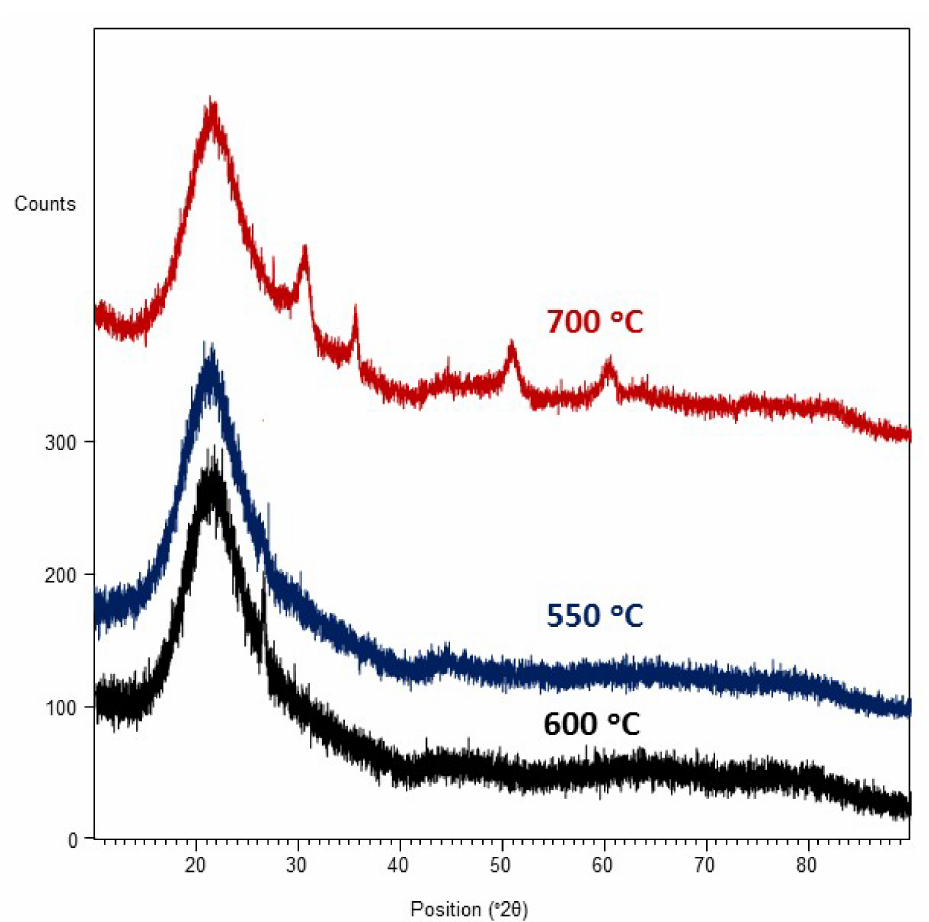
Figure 3. X-ray diffraction pattern of ZrO 2 -Gd 2 O 3 layers deposited at 550, 600, and 700 ◦ C. Molar content of Gd(tmhd) 3 in the gas reaction mixture: